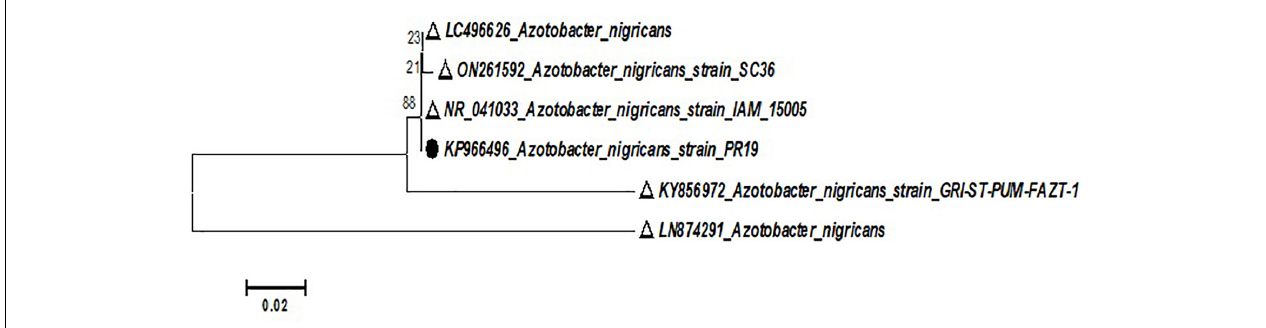
FIGURE 1 | Phylogenetic analysis of PR19 based on 16s rRNA gene sequence drawn using the Neighbor-joining tree (Kimura two-parameter distance) method (MEGA 5.0 software) with evolutionary distances.